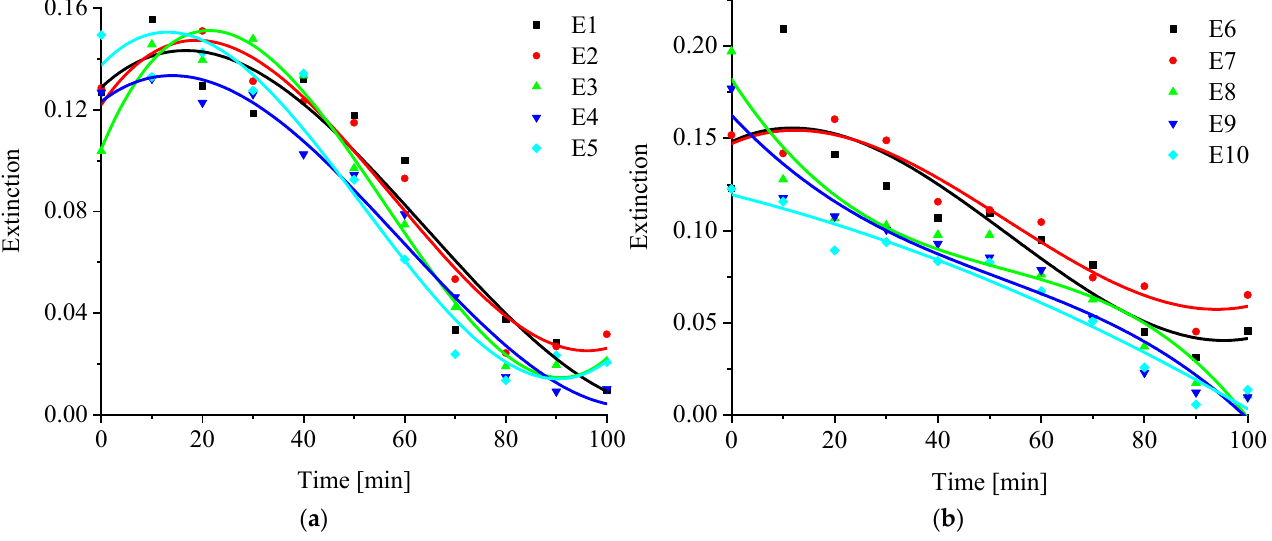
Figure 2. Diagram of photometric measurements of UV-induced degradation of ( a ) poly(PEGMEMA) ( P1 , E1–E5 ) and ( b ) PMMA ( P2 , E6–E10 ). Samples were taken every 10 min for a period of 100 min. Each experiment was fitted utilizing a cubic polynomial fit.